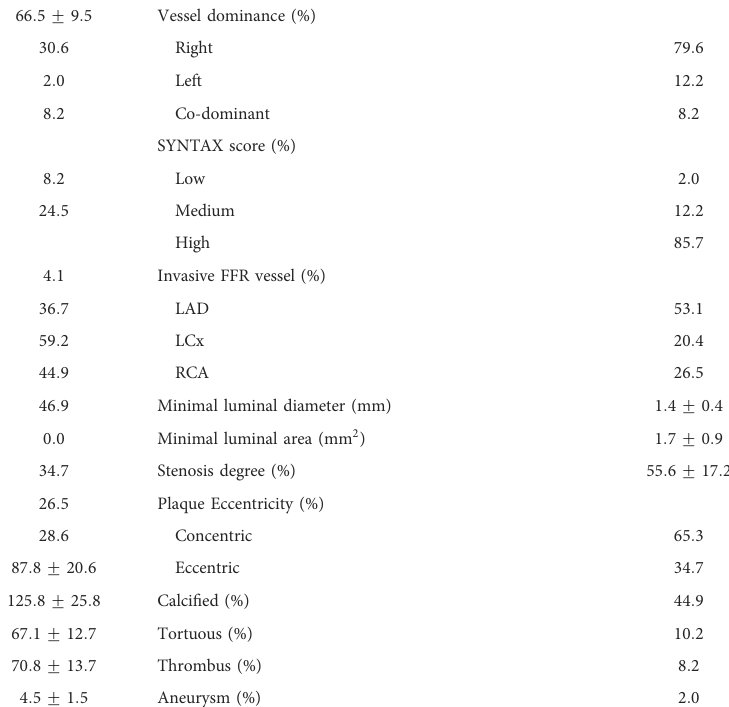
TABLE 2 Aggregated characteristics of patients ( N ¼ 50 ). TABLE 3 Aggregated characteristics of vessels ( N ¼ 50 ).